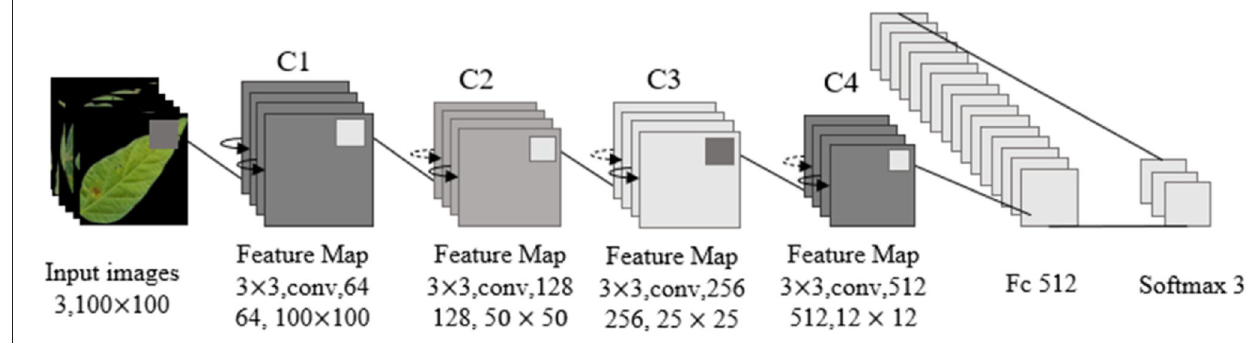
FIGURE 11 | Resnet18 network structure.